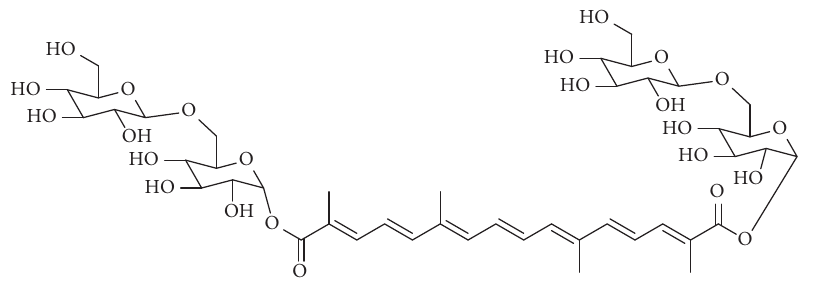
Figure 1: The chemical structure of